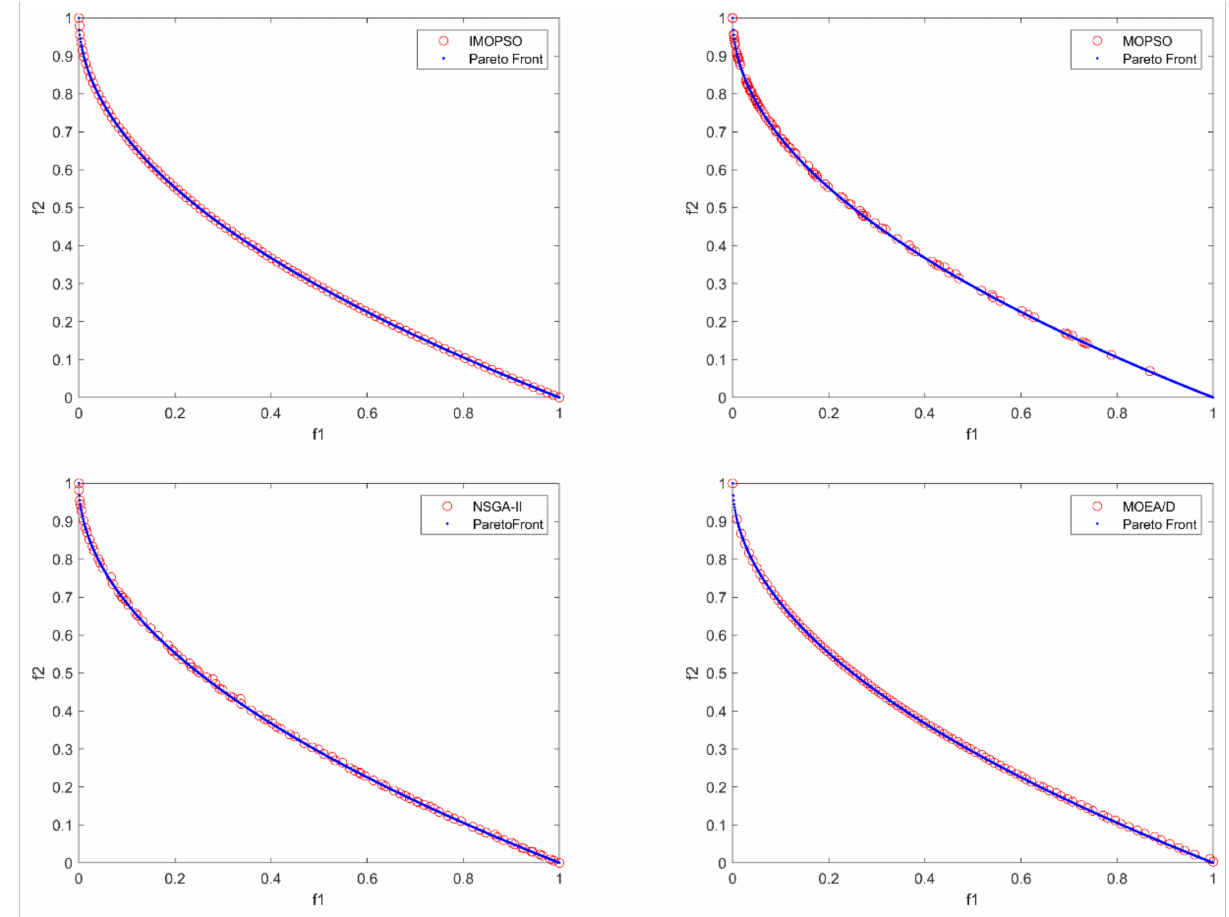
Figure 8. Comparison of the results of four algorithms for solving ZDT1